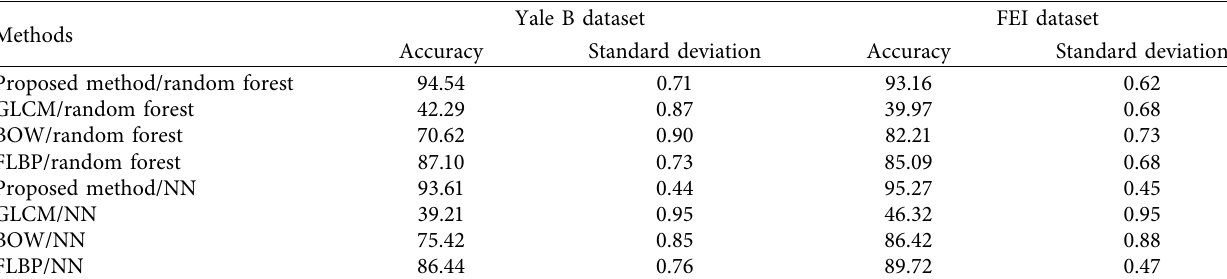
Table 6: The descriptive analysis of the five tests.